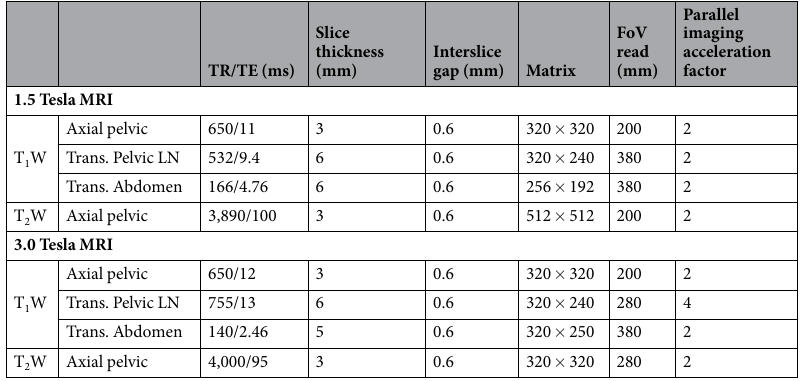
Table 2. Imaging